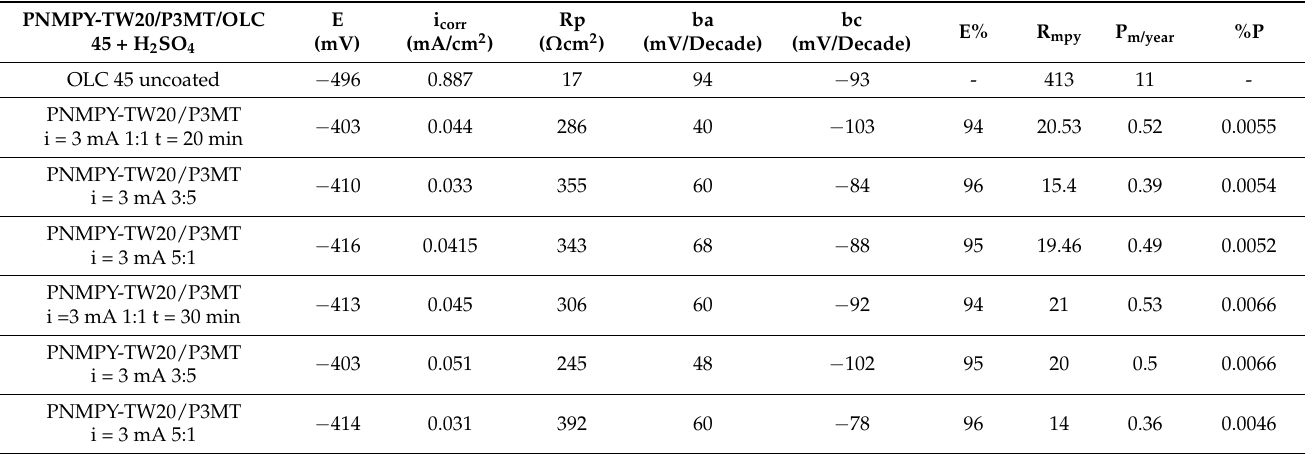
Table 1. Kinetic corrosion parameters of coated and uncoated OLC 45 sample in 0.5 M H 2 SO 4 solution at 25 ◦ C.